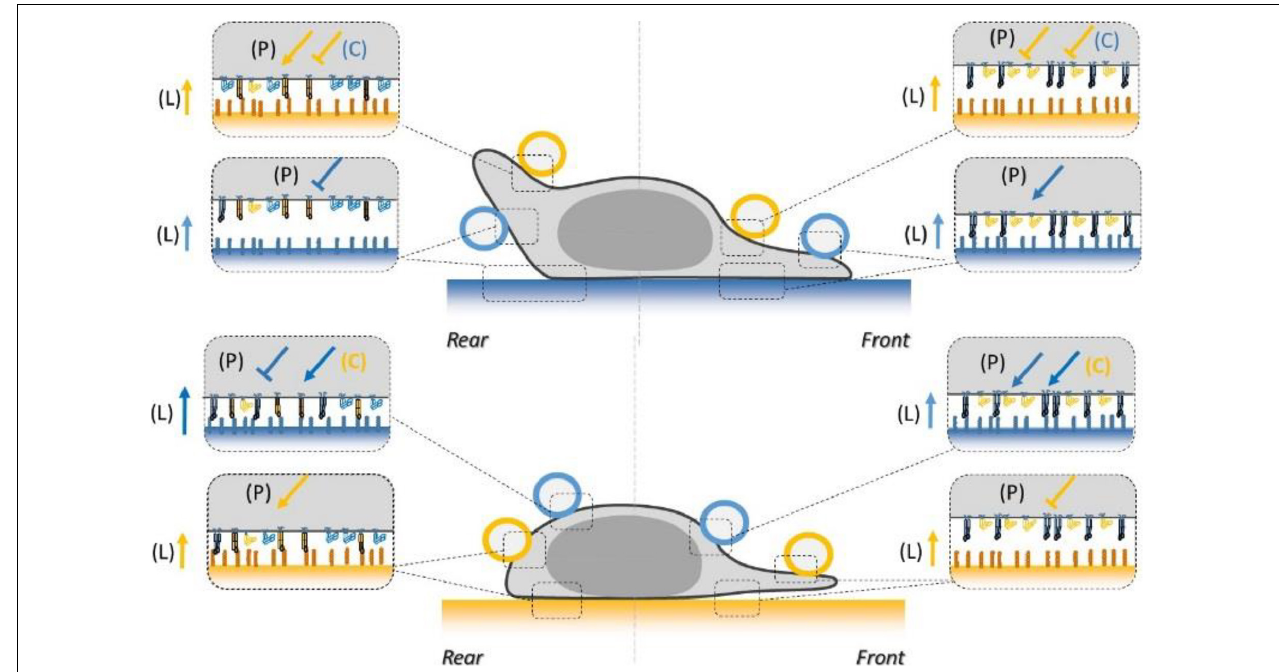
FIGURE 9 | Schematics of the combined inside-out and outside-in signals regulating LFA-1 and VLA-4 integrin affinity at the basal and dorsal surface of a human effector T lymphocyte crawling on ICAM-1 substrate (blue) or VCAM-1 substrate (orange). Integrins are represented in orange for VLA-4 and blue for LFA-1, in their high- (extended, filled) and low- (bended, hollow) affinity states. Coatings on beads and substrates are colored in blue for ICAM-1 and orange for VCAM-1. Arrows and T-lines indicate, respectively, activation and inhibiting effects, and letters indicate their origin, i.e., the polarization machinery (P), ligand bonding (L), and crosstalk